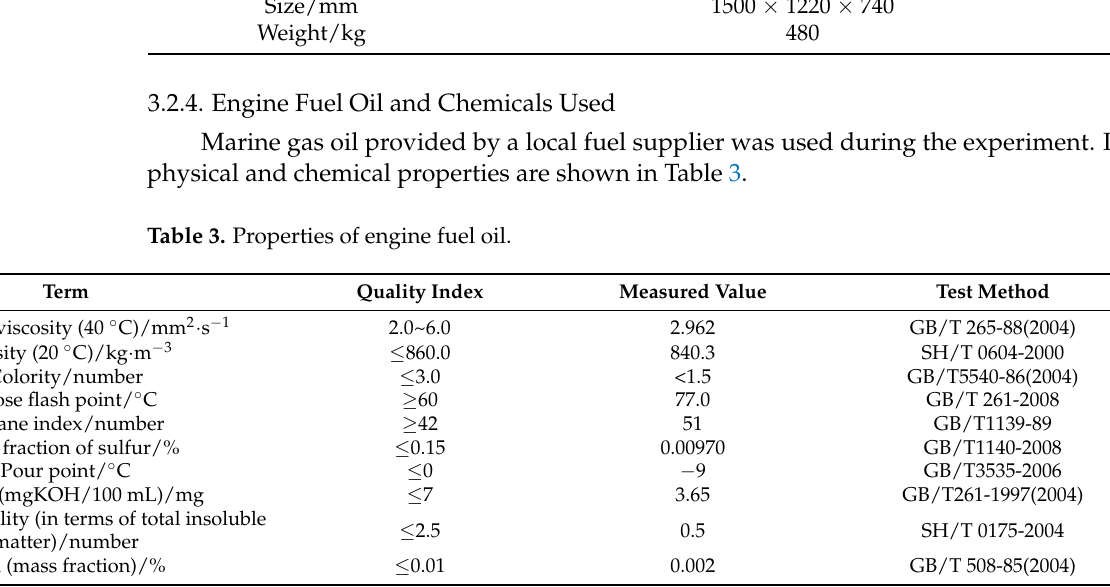
Table 3. Properties of engine fuel oil.